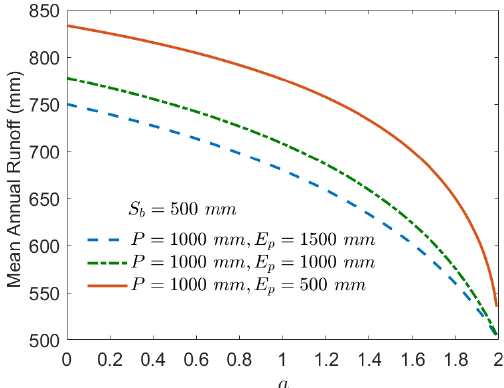
Figure 2. The sensitivity of mean annual runoff ( Q ) to the value of shape parameter ( a